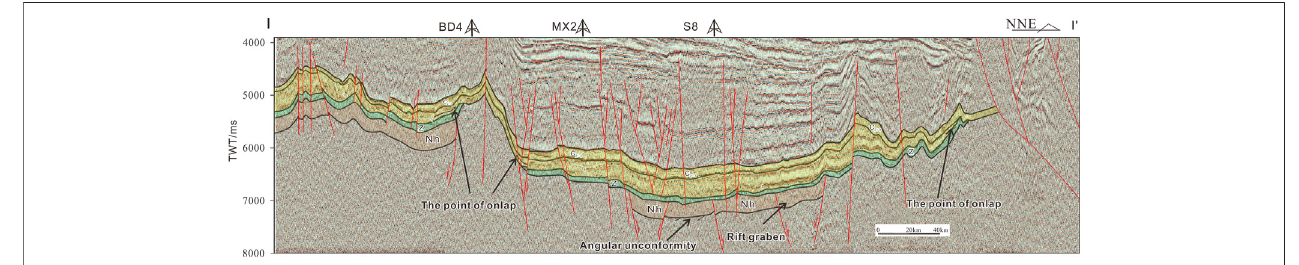
FIGURE 10 | Seismic pro fi le across the Tarim Basin showing the structural framework ( Figure 3 for locations).